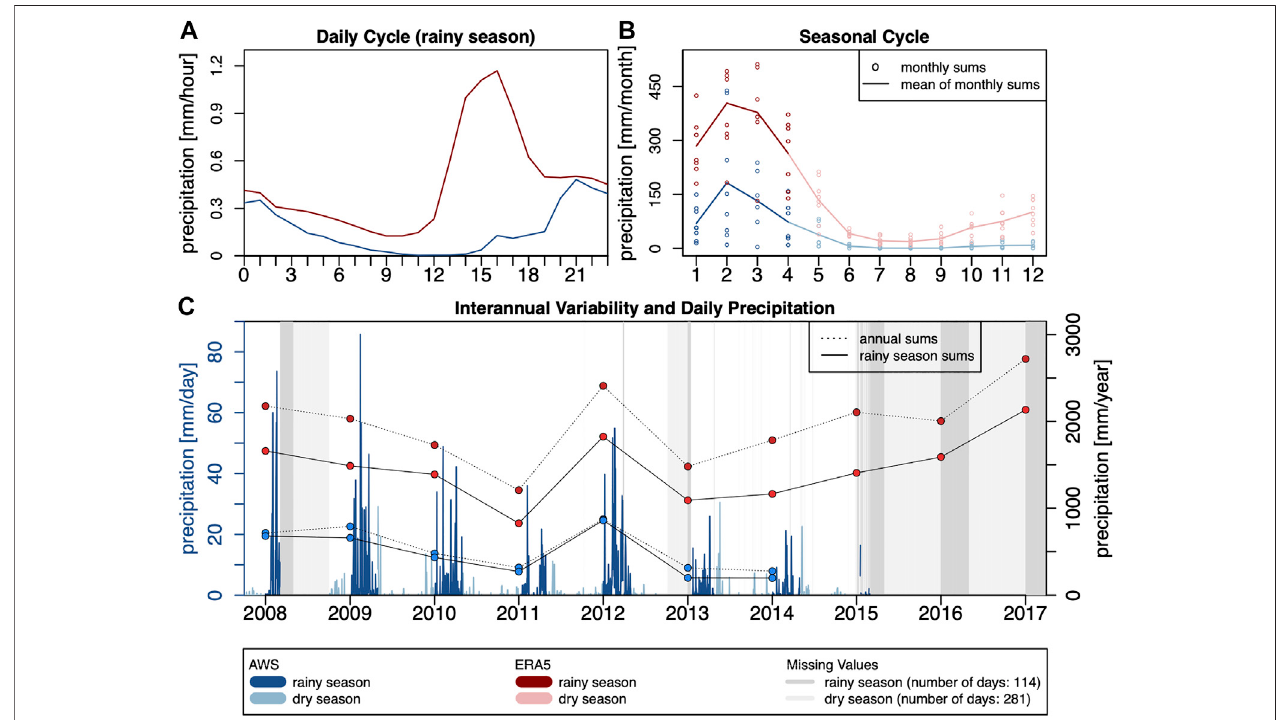
FIGURE 2 | Evaluation of the variability of ERA5 (darkred) with respect to the Valley Station (blue, AWS) considering the daily (A) as well as the seasonal cycle (B) and further the rainy season and interannual variability (C) .